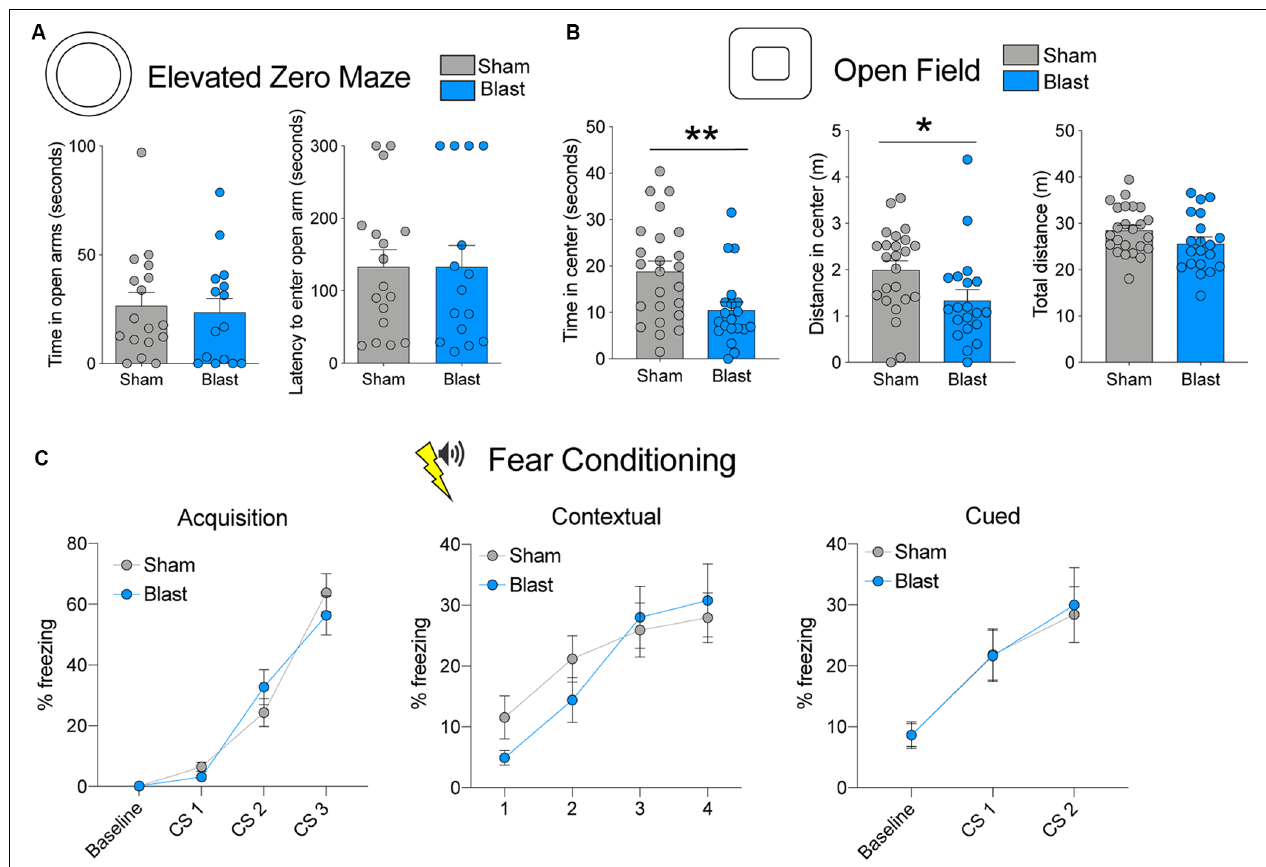
FIGURE 2 | Behavioral testing results for the sub-acute cohort. (A) Time spent in open arms and latency to enter open arms for the elevated zero maze (EZM). (B) Time spent in the center, distance traveled in the center, and total distance traveled in the open field test (OFT). (C) Percent freezing levels during acquisition, contextual fear testing, and cued fear testing (error bars represent SEM; ** p < 0.01, * p <